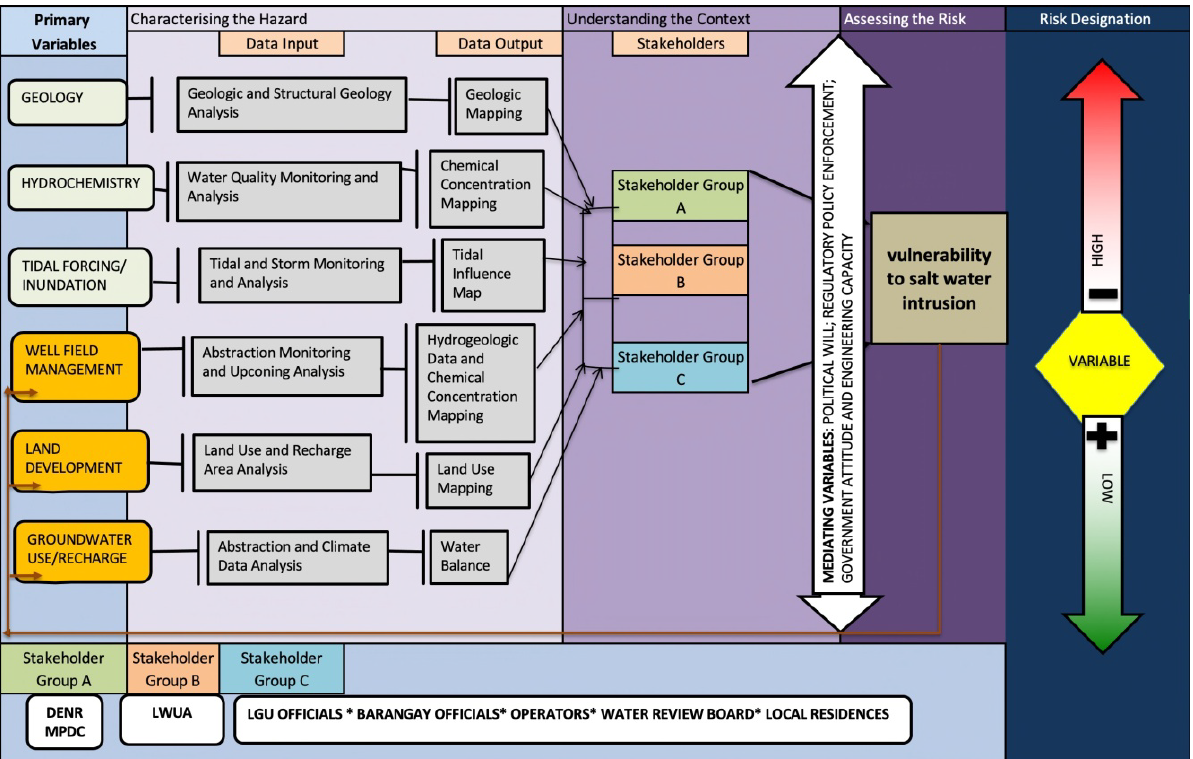
Figure 2. Vulnerability Indicator Assessment Framework with primary variables in light green (static) and dark yellow (dynamic) [15].